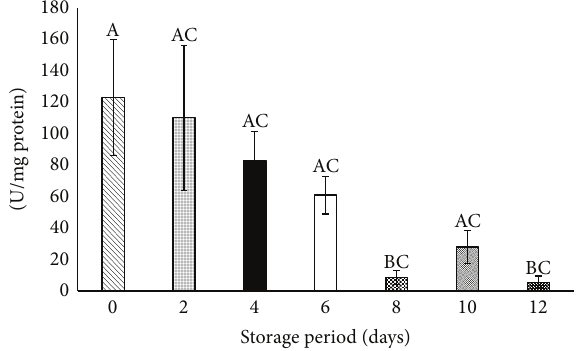
Figure 4: Catalase in stored platelets. Values are mean ± SE of five animals/group. One-way ANOVA was performed between the groups followed by Tukey-Kramer multiple comparison test, using Graph Pad Prism 6 software, and represented in upper case at 𝑃 < 0.05 . Those not sharing the same letters are significantly